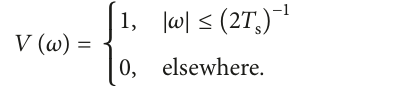
which fits perfectly into the period of the sampling